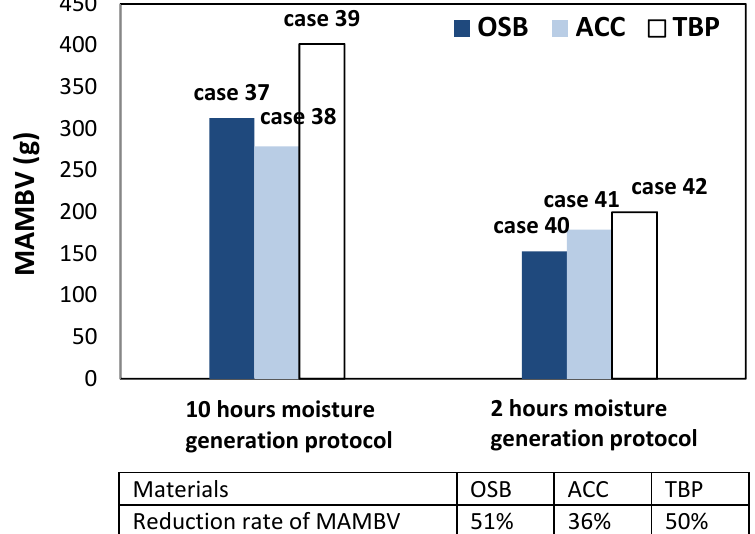
Figure 8. Maximum accumulated moisture buffering value (MAMBV) of cases using OSB, ACC and TBP as interior surface materials under two different moisture generation